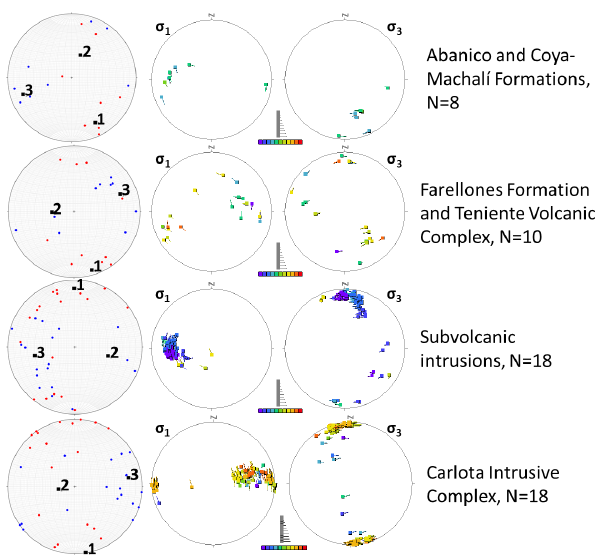
Figure 14. Kinematic and dynamic analysis of fault-plane data by lithological unit.